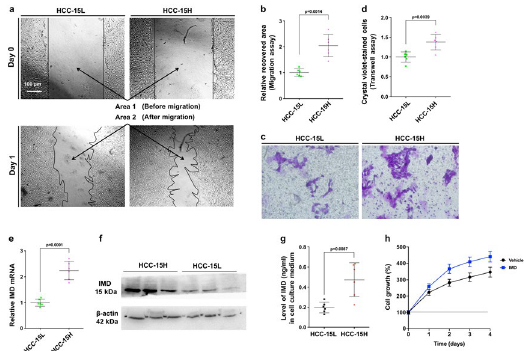
Figure 2. IMD expression was higher in more aggressive HCC cells. ( a ) The HCC-15L and HCC-15H cells were seeded on the 6-well plates. One day after cell scratching, the recovered area was measured by Area 1 (before cell migration) minus Area 2 (after cell migration). ( b ) The recovered area (the mean level of the control group was set to 1) was calculated. ( c ) Cells were seeded on the upper chamber of the transwell system. The representative images showed the cells that invaded through the membranes were stained by Crystal Violet. ( d ) The Crystal-Violet-positive cells was counted (relative to the control; the mean level in the control group was set to 1.0; n = 6.). ( e ) The relative IMD mRNA level was measured using Real-time PCR. ( f ) The protein expression level of IMD was measured by Western blot analysis (WB) using the anti-IMD mAb. ( g ) The IMD levels in medium from HCC-15L or HCC-15H culture tested by ELISA. ( h ) 1 × 10 4 HCC-15L cells were seeded on the 24-well plate and treated with vehicle or IMD for 4 days. The cell number was counted every day from day 0 to day 4, and presented relative to that of day 0. All data were presented as scatter plots with mean ± SD (n = 6). Significance was assessed by unpaired t test with Welch’s correction